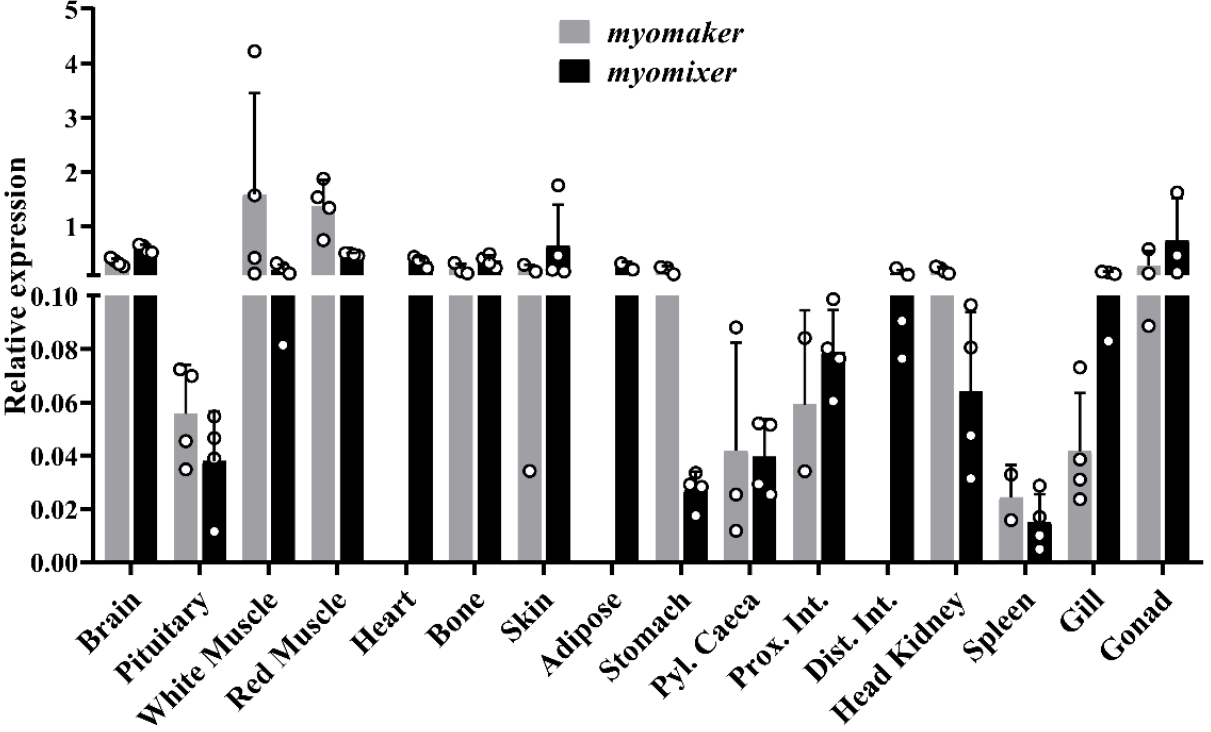
Figure 4. Bar plots of myomaker and myomixer relative gene expression in several tissues of 200 g gilthead sea bream. White-filled circles represent individual relative gene expression values. Data are presented as means + SEM ( n = 4).